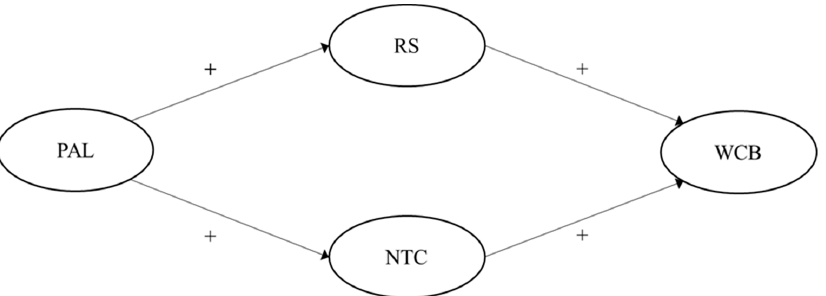
Figure 1. Hypothesized multiple mediation model for passive ‐ avoidant leadership on perceived WCB through role stress and negative team climate. Note: PAL = Passive ‐ avoidant leadership; RS = Role stress; NTC = Negative team climate; WCB = Workplace cyberbullying.